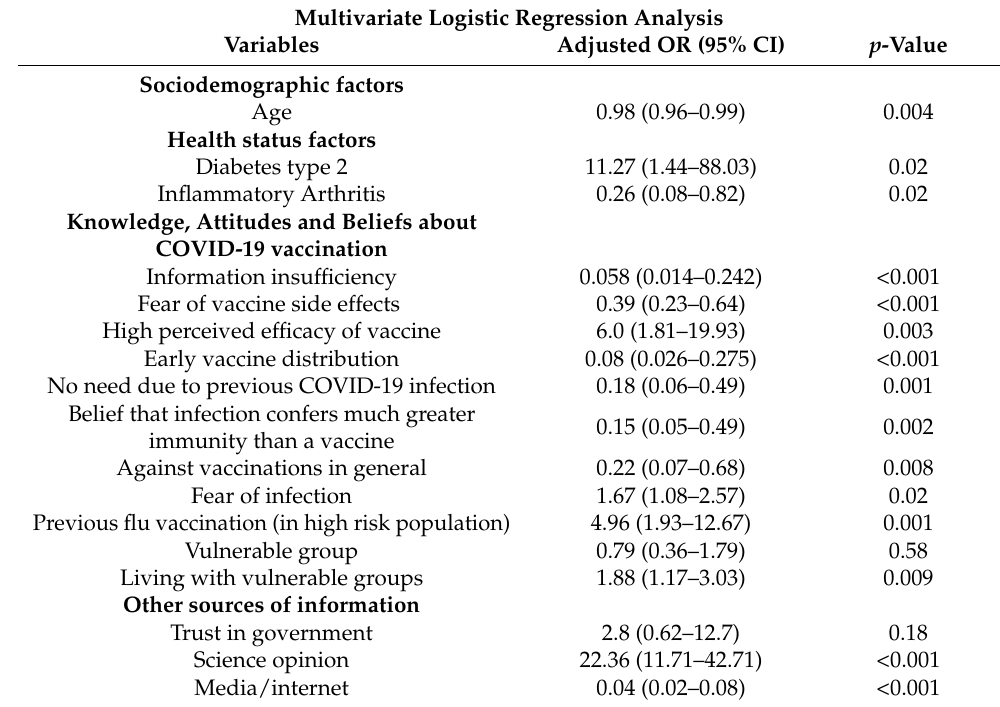
Table 5. Multivariate logistic regression analysis of factors associated with COVID-19 vaccine uptake ( n =